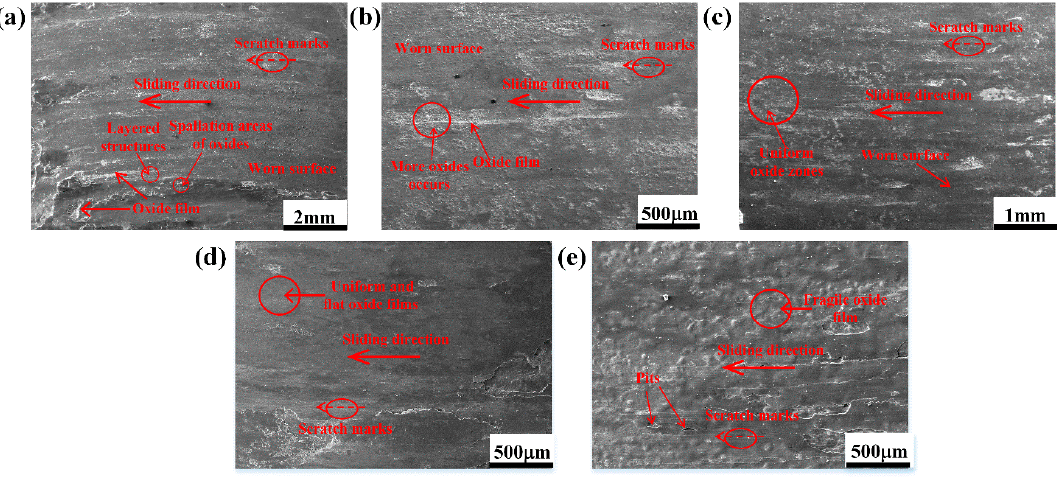
◦ C for 50 N: ( a ) A1, ( b ) A2, ( c ) A3, ( d ) A4, ( e ) Figure 6. Surface morphologies of HBHSSs at 800 °C for 50 N: ( a ) A1, ( b ) A2, ( c ) A3, ( d ) A4, ( e ) M2. Figure 6. Surface morphologies of HBHSSs at 800